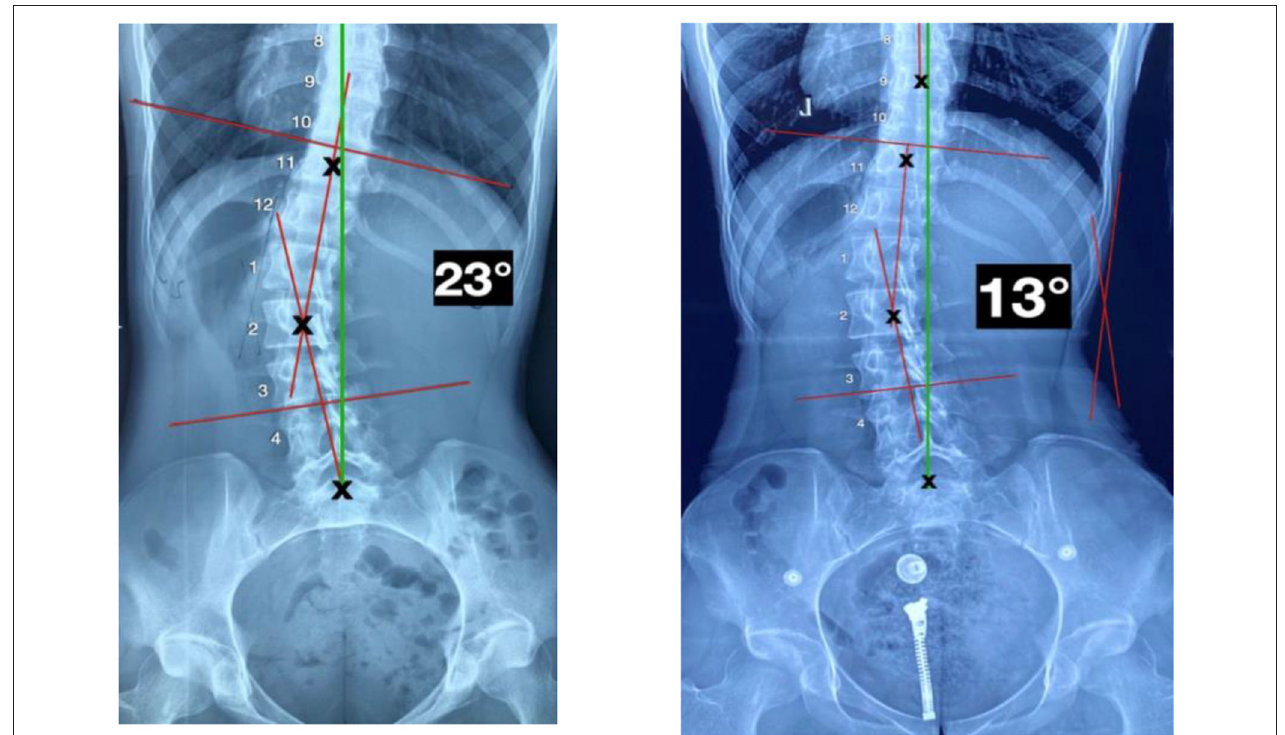
FIGURE 3 | P-A X-ray views. Left : Initial image showing a cobb angle of 23 ◦ . Right : Image showing a cobb angle of 13 ◦ .